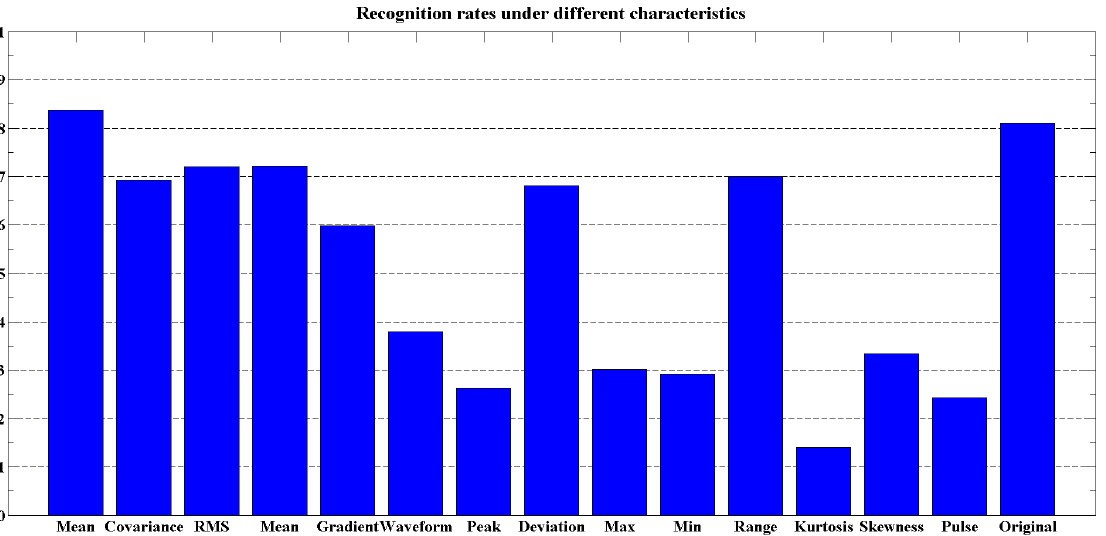
Figure 10. Recognition rate of eigenvalues with sliding window size of